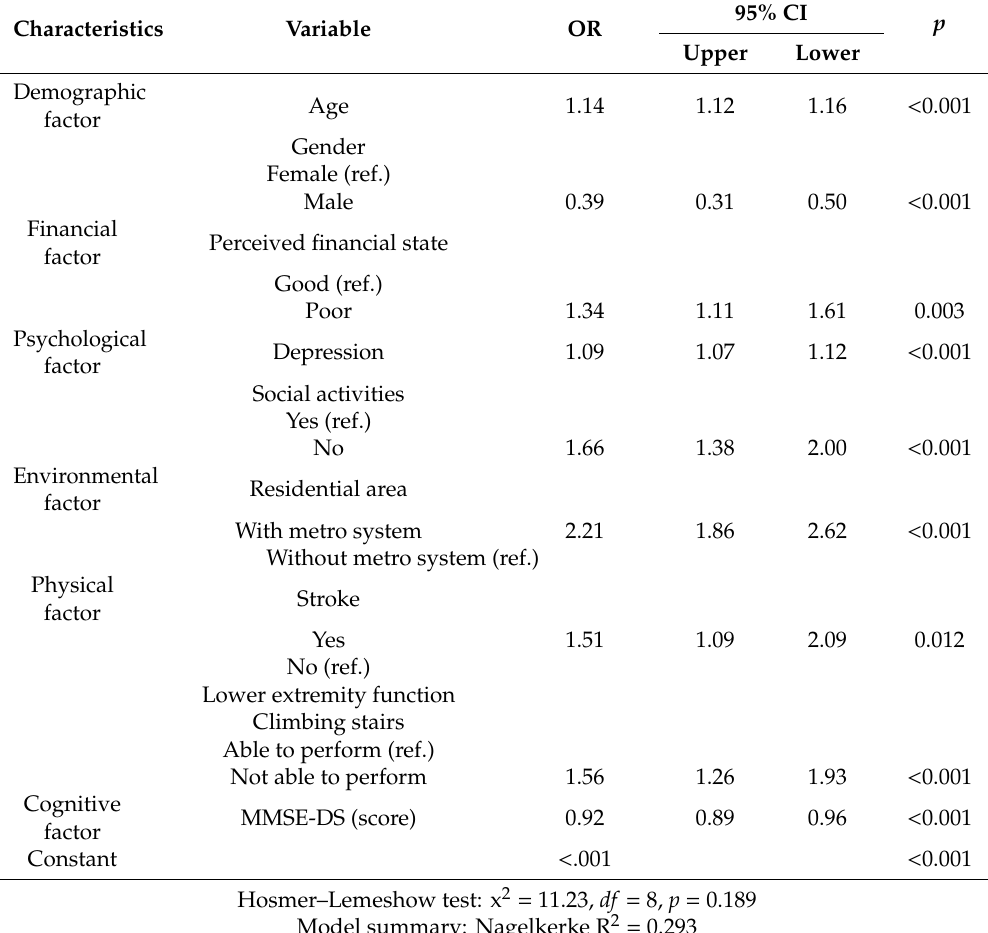
Model summary: Nagelkerke R 2 = 0.293